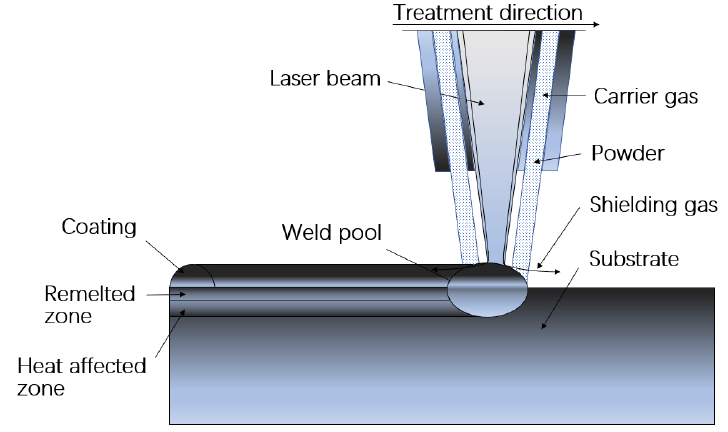
Figure 3. Schematic diagram of the laser cladding process.